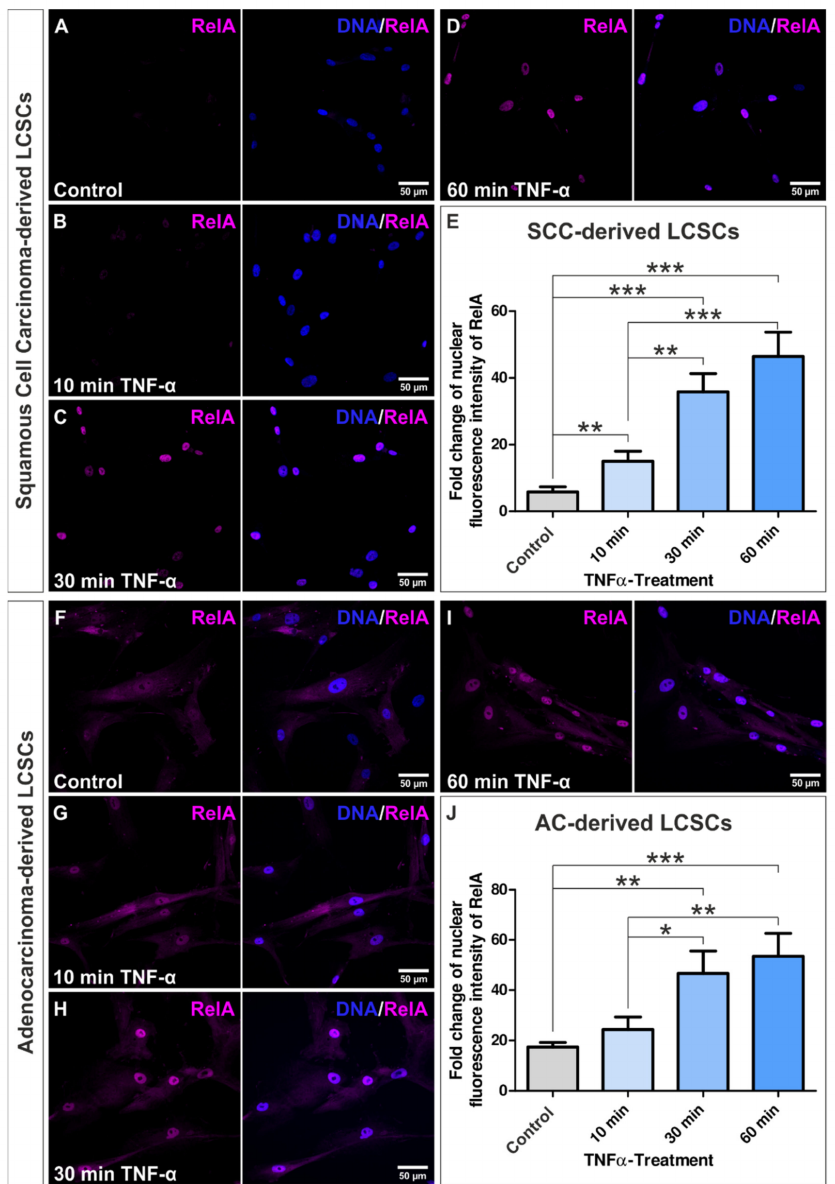
Figure 3. Tumor necrosis factor α (TNF- α ) stimulation of non-small cell lung cancer-derived lung cancer stem cell (LCSC)-like cells activated NF- κ B subunit RelA. Representative pictures of im- munocytochemical staining for RelA of ( A ) untreated squamous cell carcinoma-derived BKZ-5 cells (control) and BKZ-5 cells after stimulation with TNF- α for ( B ) 10 min, ( C ) 30 min, and ( D ) 60